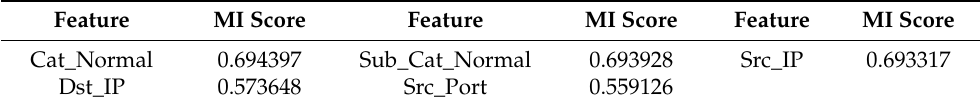
Table 6. Top Features with MI score ≥ 0.5.